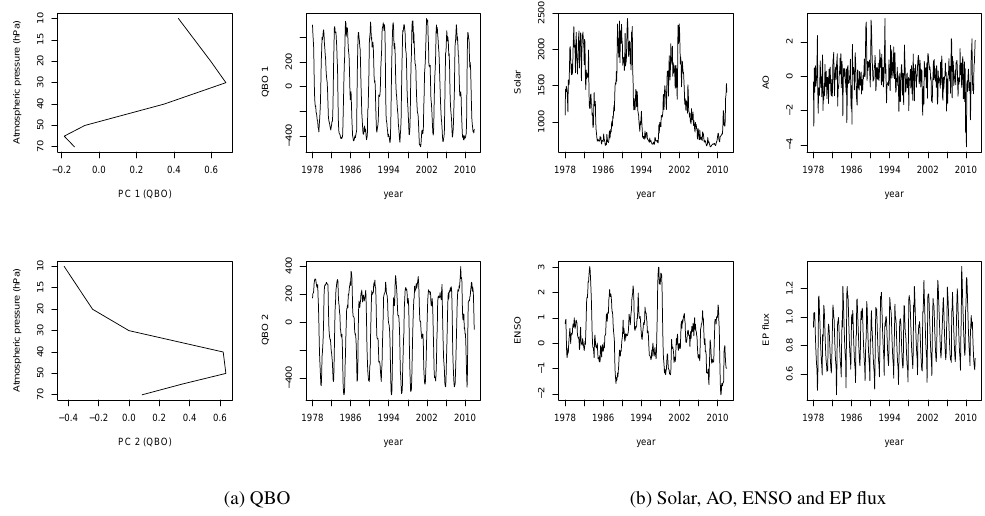
Fig. 5. Covariate: (a) QBO: PC 1 and PC 2 correspond to the first and the second dominant modes in the QBO; QBO1 and QBO2 are scores associated with PC 1 and PC 2. (b): Time series of covariates (solar, AO, ENSO and EP flux).